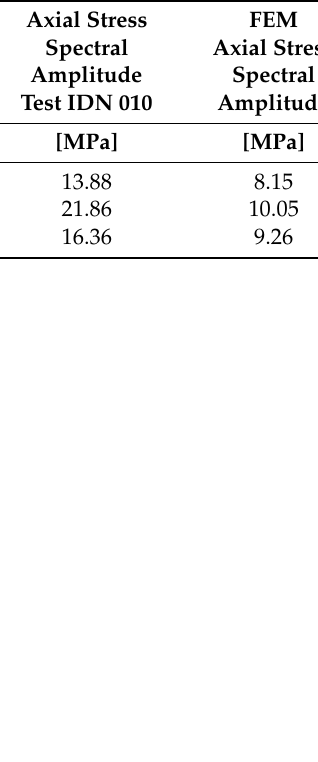
Figure 12. Measured and computed spectra for the torsional stress wave. Blackline shows computed spectrum while light grey curves provide the measured spectra for the test IDN 020.